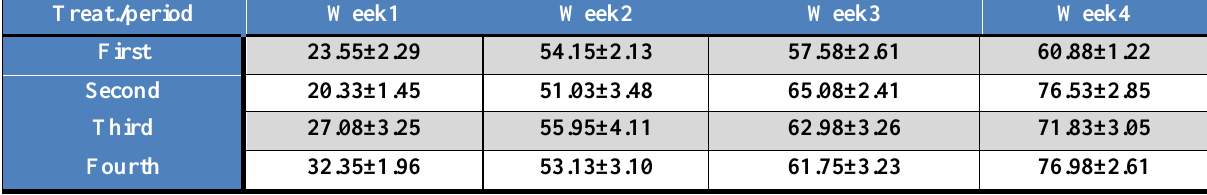
Table, 12: Effect of Vit. C and/or Vit.B on the Alkaline phosphatase activity (ALP, IU/L) of rabbits (Mean ± SE). Treat./period